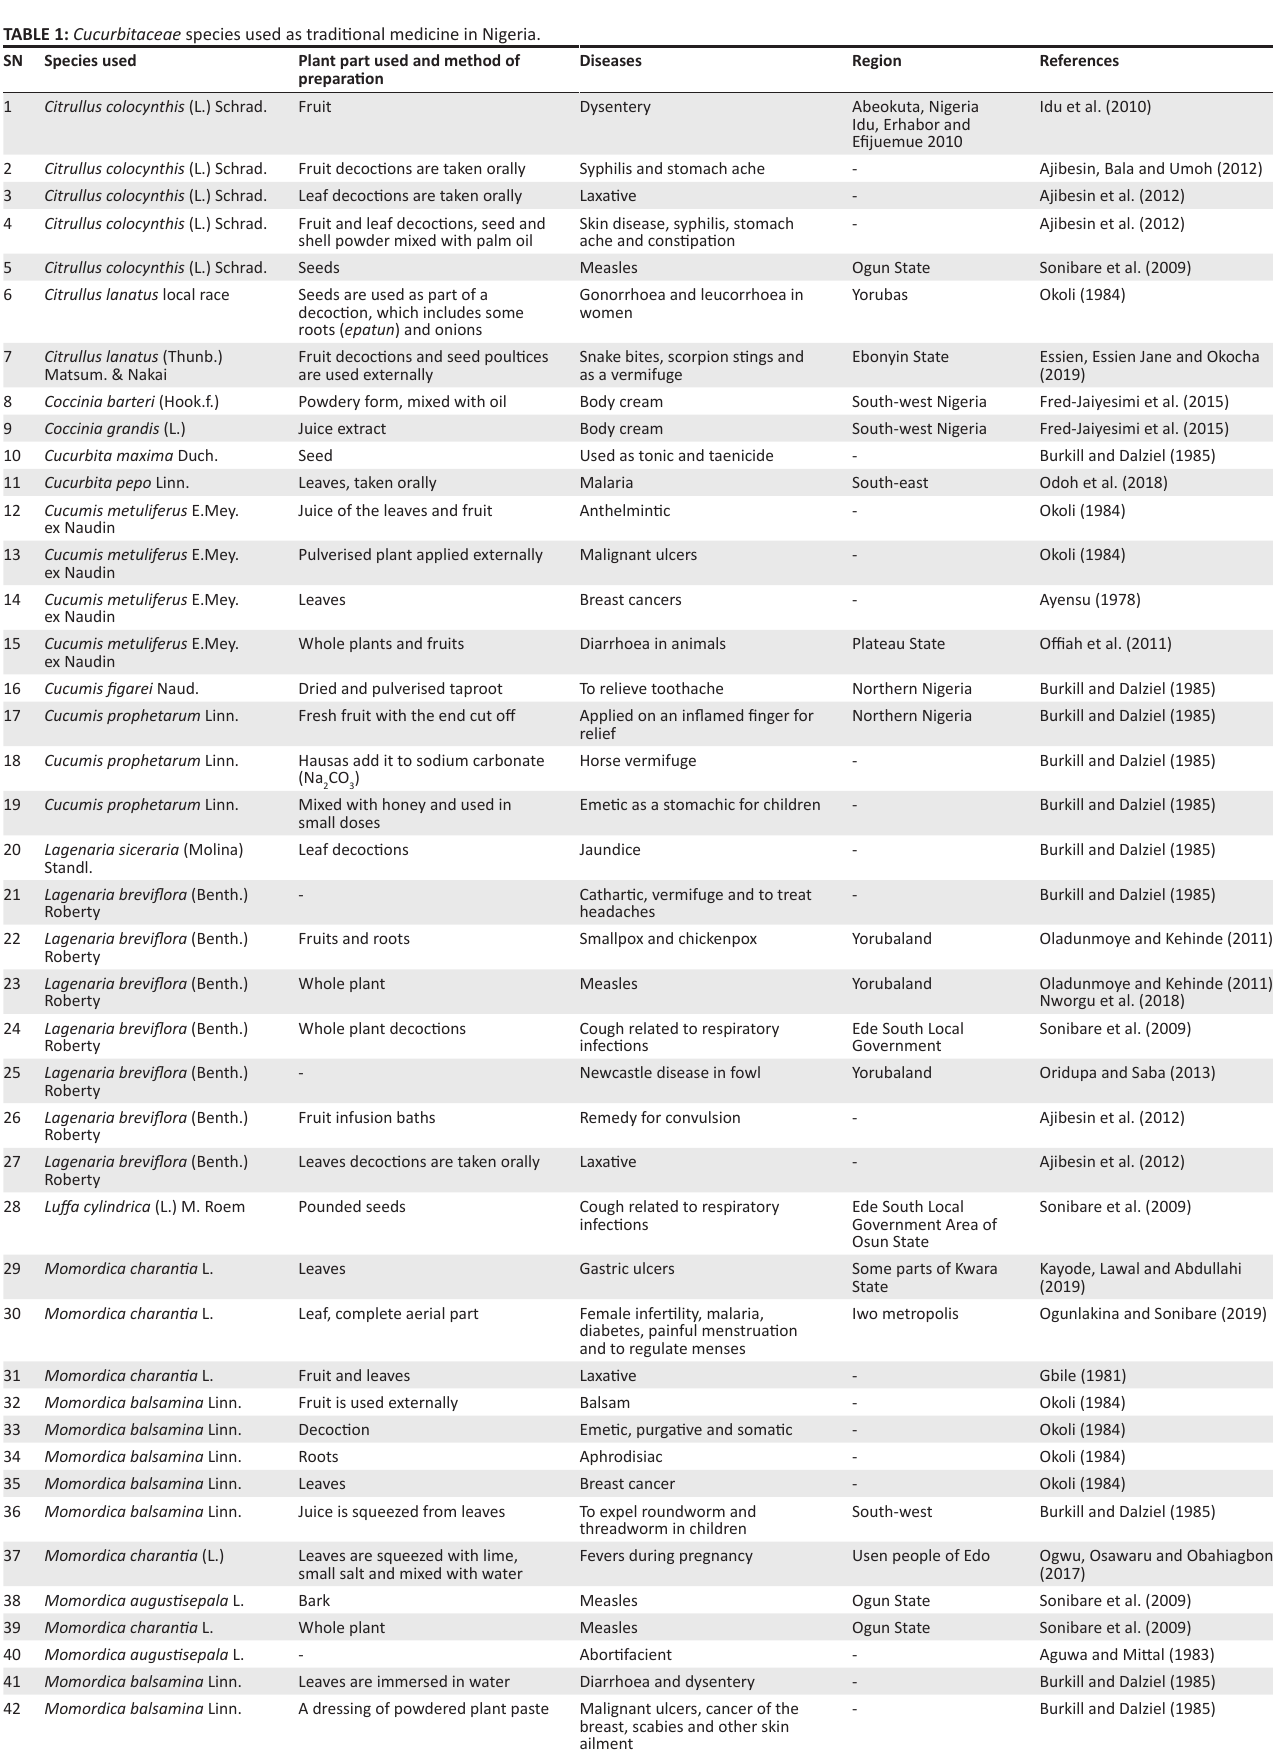
TABLE 1: Cucurbitaceae species used as traditional medicine in Nigeria. SN Species